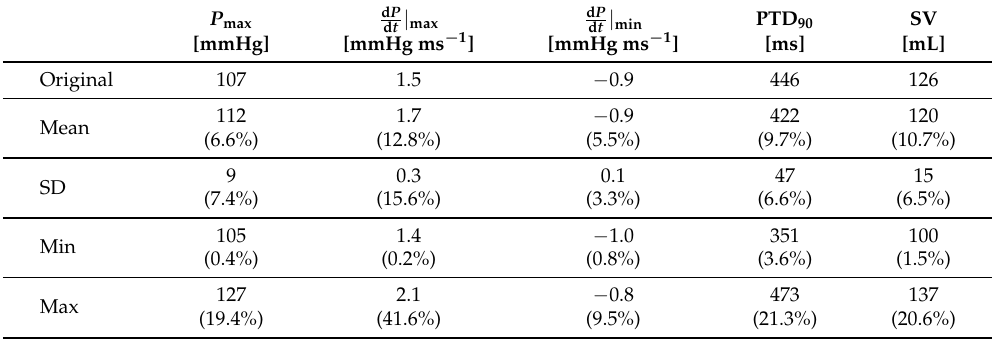
Table 10. Results of the initial guess variation robustness analysis for the patient case 02-CoA. Pressure and volume biomarker values of the second step of the active mechanics personalisation approach are given. The original values produced by the default initial guesses are listed in the first row and means (M), standard deviations (SD), minima (Min), and maxima (Max) of five samples are listed in the subsequent rows. Means, standard deviations, minima, and maxima of the relative differences are given in brackets